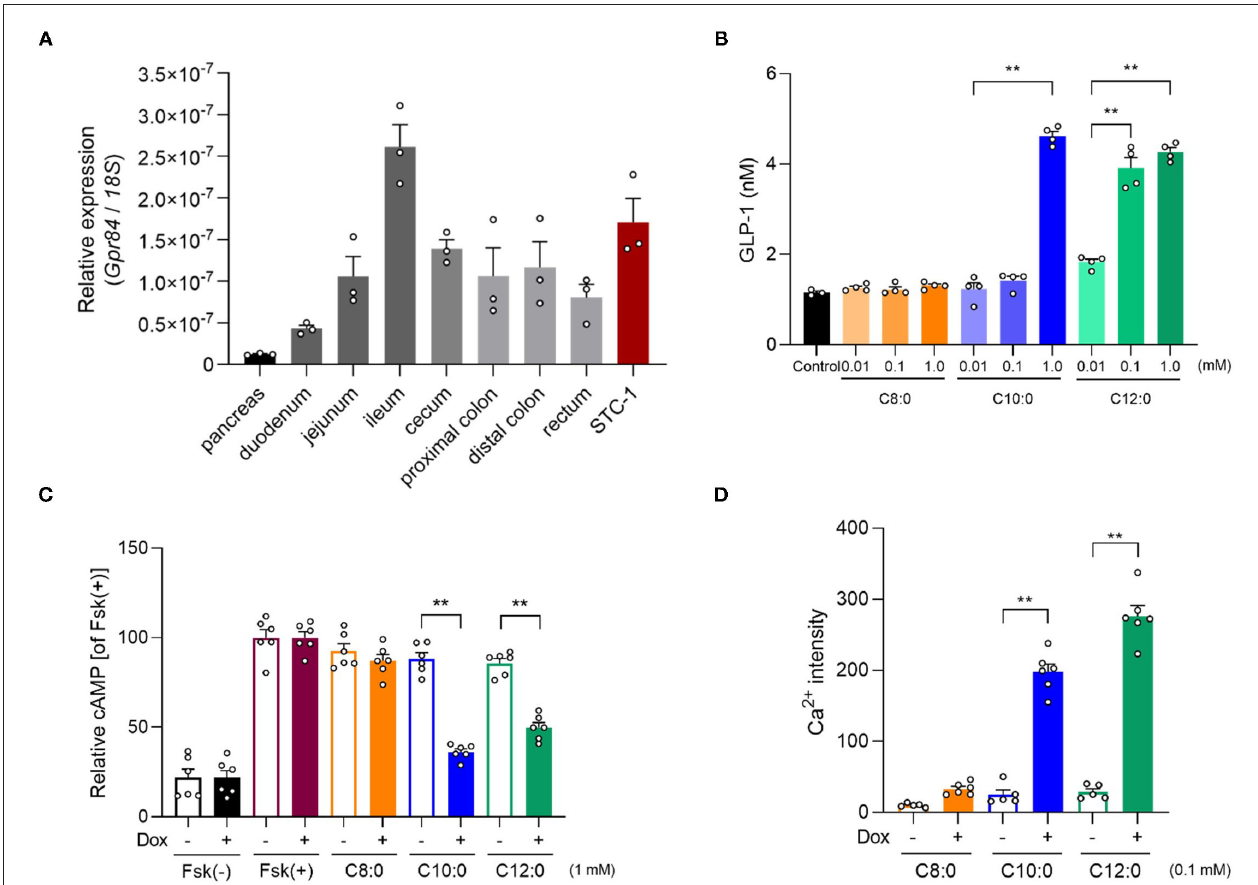
FIGURE 3 | Medium-chain fatty acid (MCFA) decanoate (C10:0) and dodecanoate (C12:0) promotes GLP-1 secretion in STC-1 cells. (A) Expression of Gpr84 in the pancreas, small intestine (duodenum, jejunum, and ileum), cecum, colon (proximal and distal colon), and STC-1 cells ( n = 3). (B) GLP-1 levels in response to MCFAs (0.01, 0.1 or 1mM, respectively) in STC-1 cells ( n = 3–4). (C) cAMP inhibition assay for MCFAs (1mM, respectively) using GPR84-expressing HEK293 cells. Cells were cultured for 24h and then treated with or without 10 µ g/mL of doxycycline (Dox, n = 6). All data are presented as relative to the forskolin (Fsk)-induced cAMP levels. (D) Mobilization of intracellular calcium ([Ca 2 + ]i) induced by MCFAs (0.1mM, respectively) was monitored using GPR40-expressing HEK293 cells. Data are presented as Ca 2 + intensity. Cells were cultured for 24h and then treated with or without 10 µ g/mL of Dox ( n = 5–6). ** P < 0.01 (Tukey-Kramer test). These experiments were performed using independent cultures from two biological replicates. All data are presented as the mean ± standard error of mean (SEM).